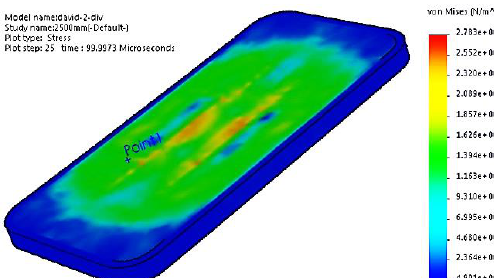
Fig. 4. Stress Distribution for a cellphone with Two Casing Laminate at 2500mm Drop